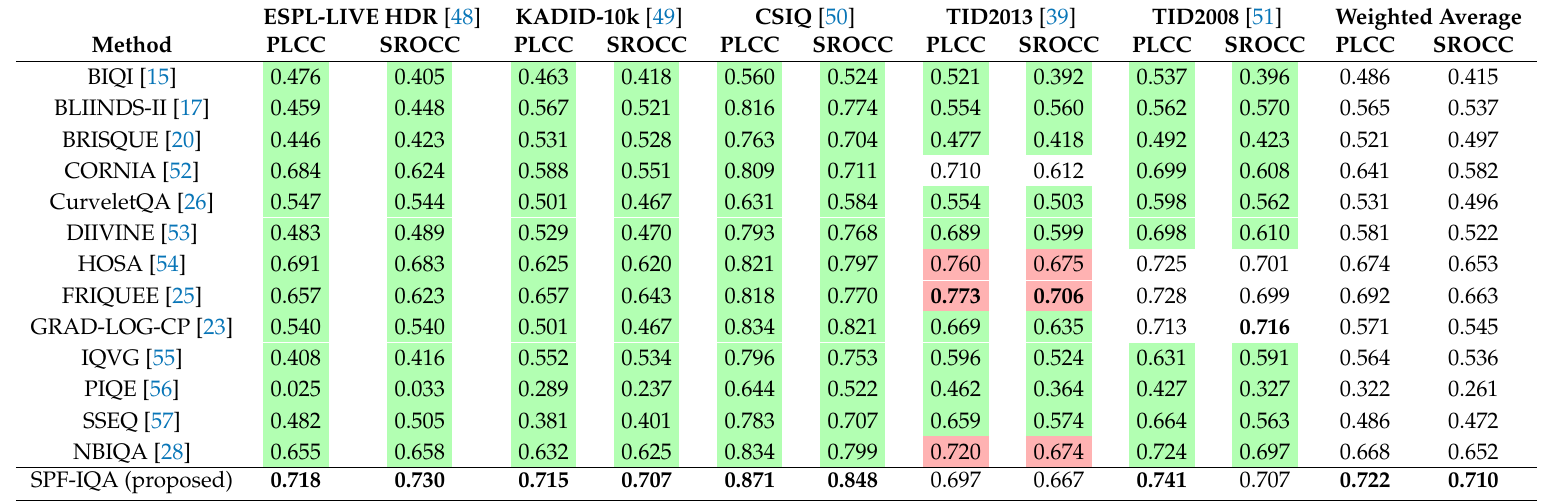
Table 5. Comparison to the state-of-the-art on ESPL-LIVE HDR [48], KADID-10k [49], CSIQ [50], TID2013 [39], and TID2008 [51]. Mean PLCC and SROCC values were measured over 20 random train-test splits. The best results are typed in bold . The green background color stands for that the correlation is lower than those of the proposed method and the difference is statistically significant with p < 0.05, while the red background color means the correlation is higher and the difference is statistically significant with p <